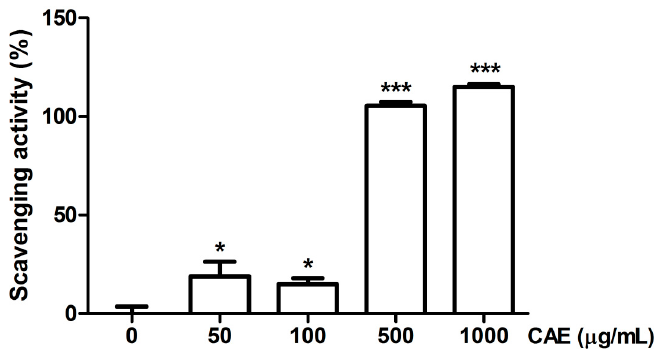
Figure 5. Hydrogen peroxide scavenging activity (%) of CAE. A significant difference between this activity and that of the untreated (0 µ g/mL CAE) group can be observed. Significant difference versus control in each experiment: *, p < 0.05, ***, p < 0.001.